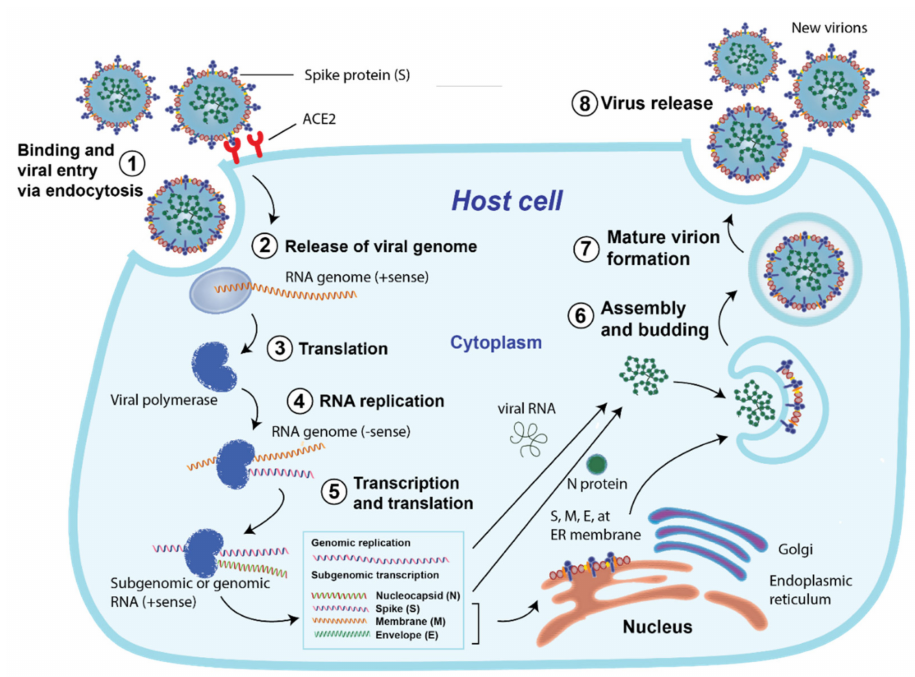
Figure 2. SARS CoV-2 life cycle: (1) Binding and viral entry to the host cell via endocytosis; (2) release of viral genome; (3) translation and (4) replication of RNA genome; (5) transcription and translation of RNA into protein; (6) assembly and budding, followed by (7) mature virion formation; and (8) release of the new virion from the host cell. (Redrawn by the authors based on second figure in Ref.